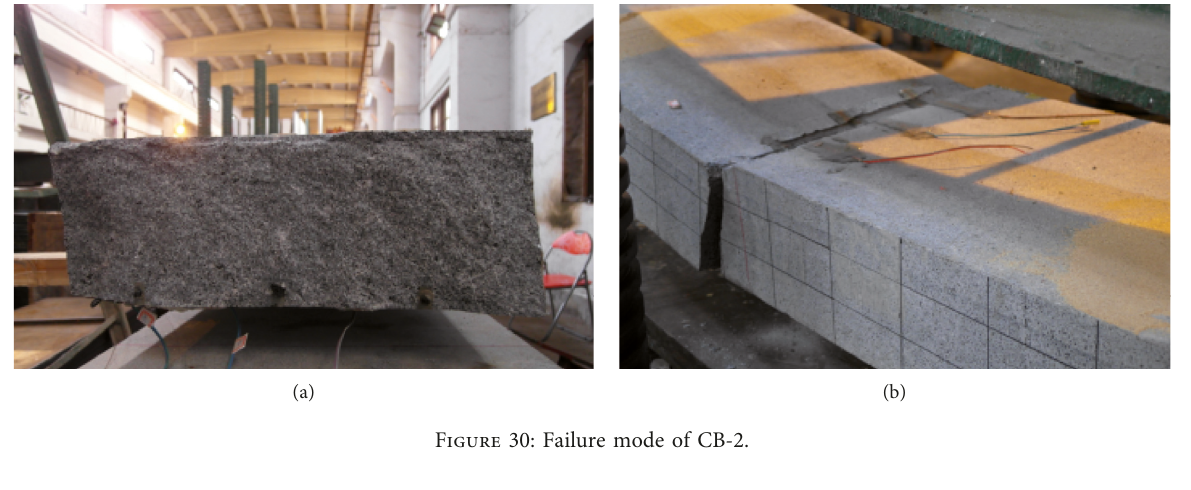
Figure 30: Failure mode of